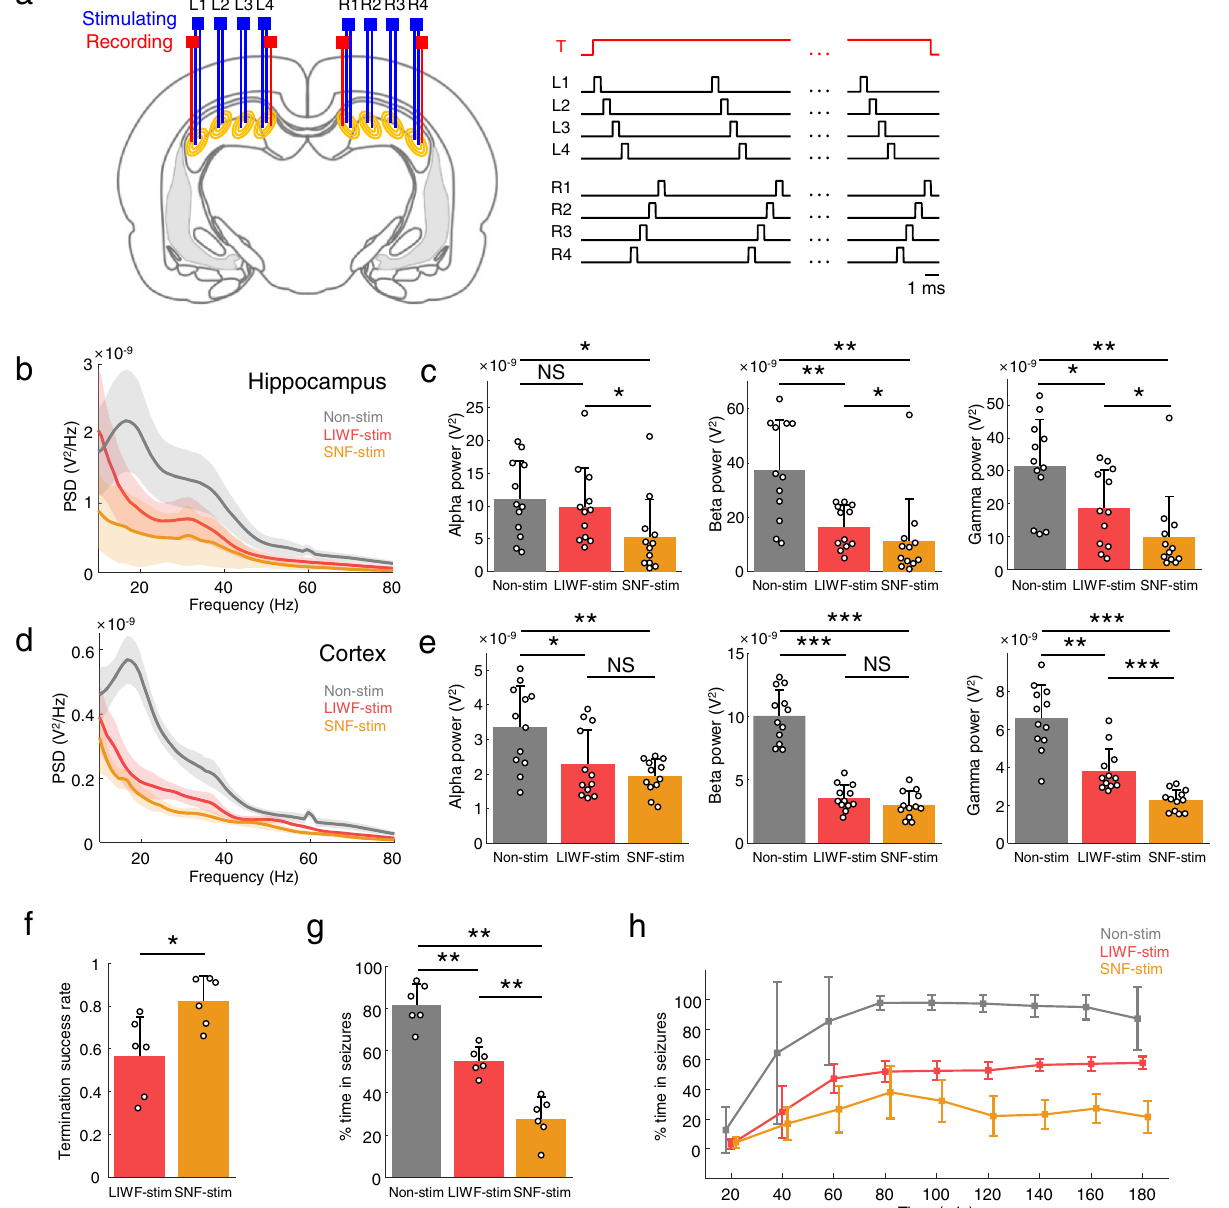
Fig. 5 | Comprehensive analysis of SNF stimulation for suppressing seizures. a Schematic depicting the bipolar and tripolar depth electrodes implanted bilat- erally for SNF stimulation (left). Experimental protocol for SNF stimulation (right). When a trigger signal is generated by the detection algorithm, current stimuli are sequentially applied to the electrodes. b – e Comparison of power spectra. b , d Power spectral density (PSD; Welch ’ s method with 1s windows and 0.5s overlap) for the non-stimulation (gray), LIWF stimulation (coral-red), and SNF sti- mulation (orange) groups. Lines represent the means and shaded areas represent SD. c , e Average power for the alpha, beta, and gamma frequency bands from the hippocampus( c P (alpha)=0.019, P (beta)<0.001,and P (gamma)=0.0016, n =12in all comparisons, Kruskal – Wallis test with Bonferroni correction) and cortex ( e P (alpha)=0.01, P (beta)<0.001,and P (gamma)<0.001, n =12inallcomparisons,